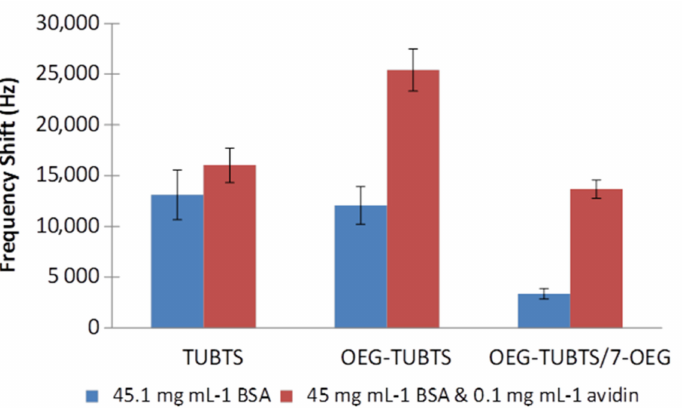
Figure 10. EMPAS frequency shifts measured with 45.1 mg mL − 1 BSA and 45 mg mL − 1 BSA with 0.1 mg mL − 1 avidin solutions in PBS, using biotinylated TUBTS, OEG–TUBTS, and OEG–TUBTS/7– OEG